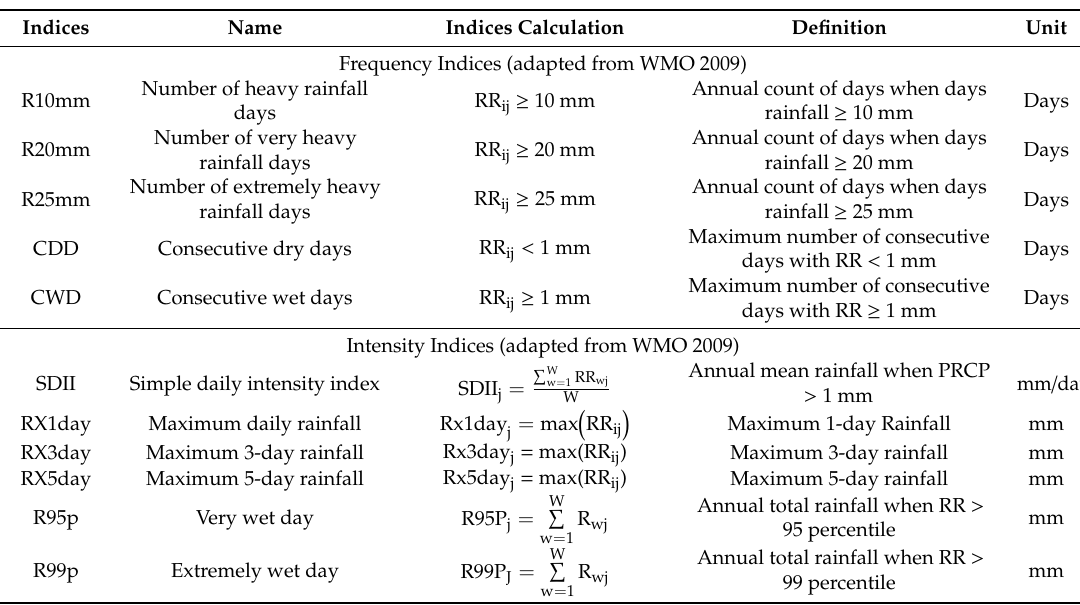
Table 3. Definition of